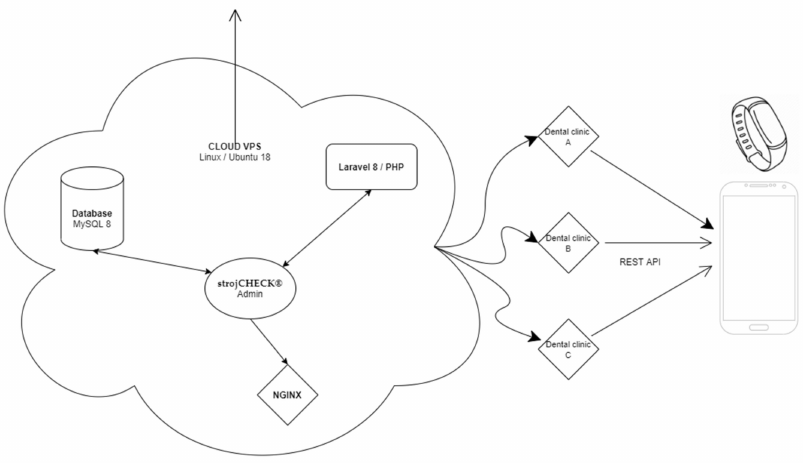
Figure 3. Global schematics of technological platforms fundamental to the complex system of StrojCHECK ® from the back-end server through different dental clinics with their separate adminis- trator portals up to end-user devices.